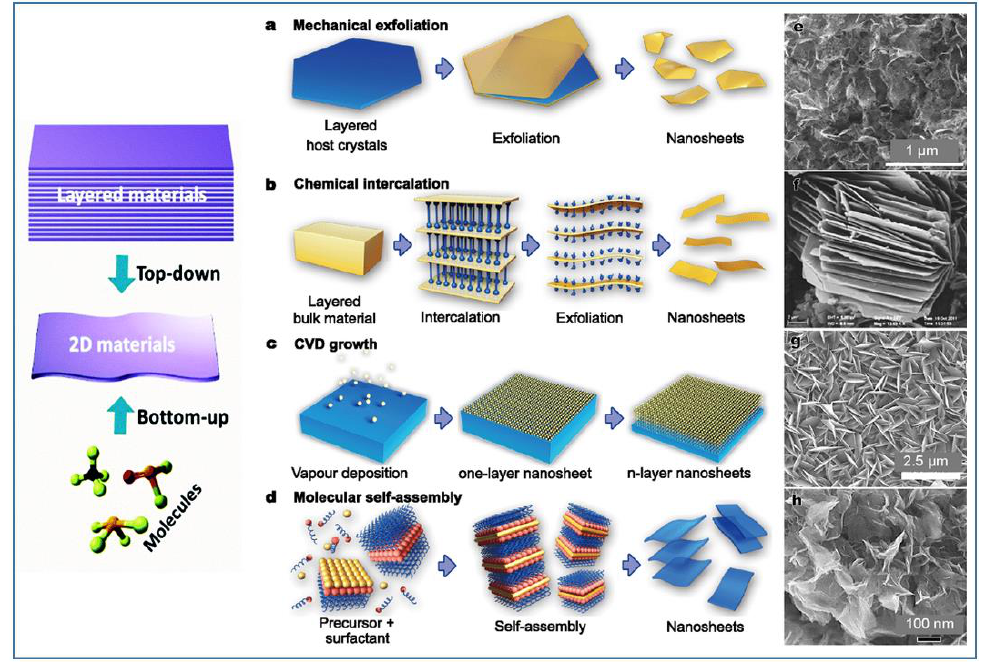
Figure 2. Examples of top-down and bottom-up strategies for the synthesis of 2D layered nanostructures: ( a ) mechanical exfoliation of layered host materials, ( b ) chemical intercalation induced exfoliation, ( c ) chemical vapor deposition (CVD) growth, and ( d ) wet-chemical self-assembly. Scanning electron microscopy (SEM) images of 2D nanomaterials obtained with the corresponding techniques: ( e , g , h ) TiO 2 and ( f )VO 2 nanosheets.